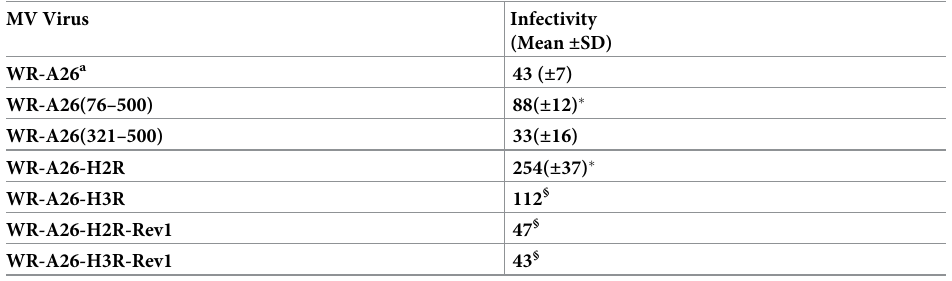
Table 1. MV particle infectivity of WR-A26(76–500), WR-A26(321–500), WR-A26-H2R, WR-A26-H3R and the revertant viruses. MV